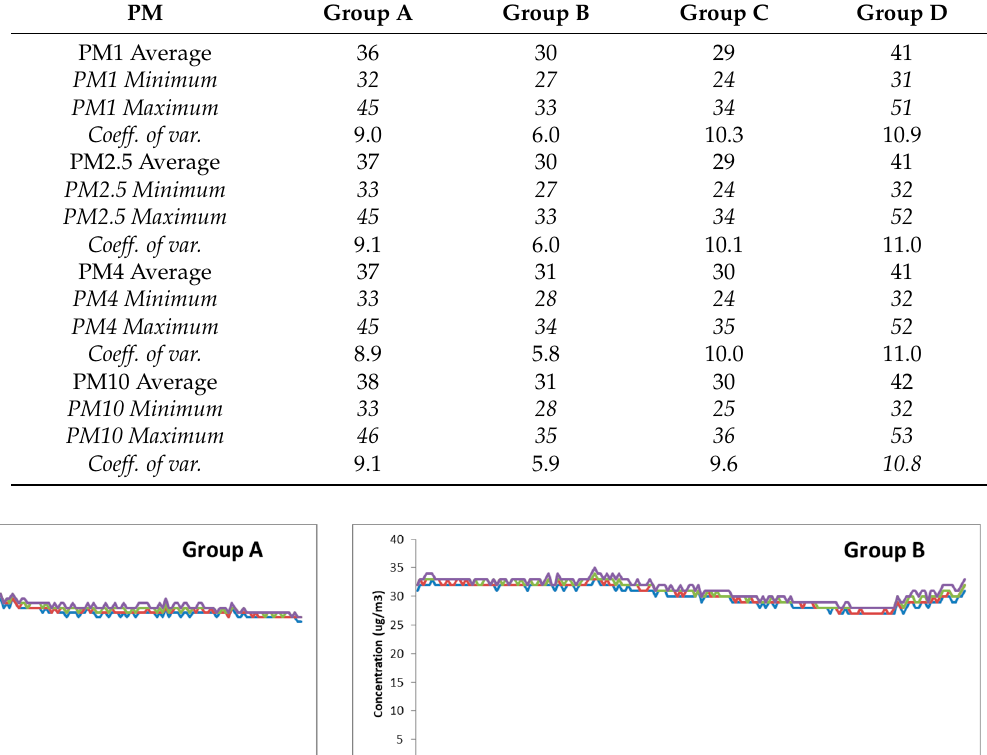
Table 2. Concentration of the size segregated mass fractions of particulate matter ( µ g m − 3 ) recorded in a classroom using a TSI DustTrak TM DRX 8533 EP monitor during 3 h of lecture in the presence of students (Group A and B—without wearing masks; Group C and D—wearing disposal face masks).